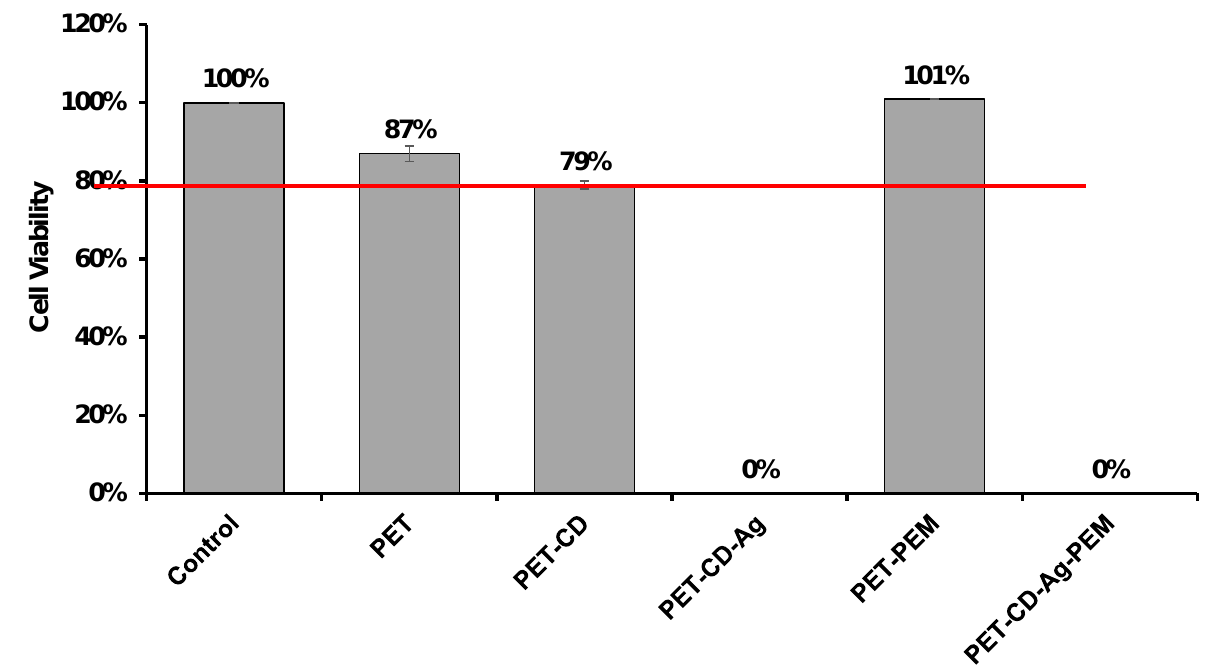
Figure 8. Cell viability of L132 line cell evaluated on different textiles by the extraction method after 24 h of incubation (n = 8).